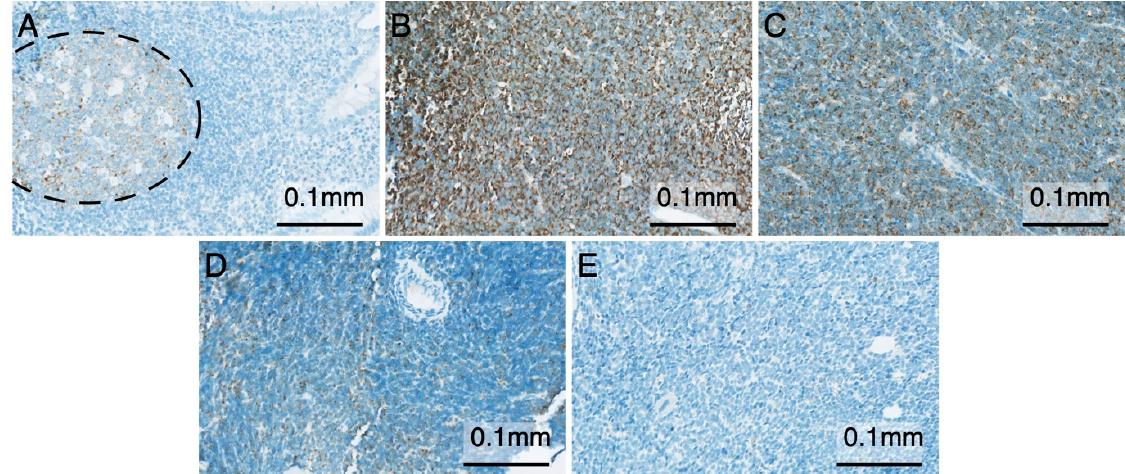
Figure 1. Immunohistochemistry of insulin-like growth factor II mRNA-binding protein 3 ( IGF2BP3 ). ( A ) Appendix showing positivity (brown color) to IGF2BP3 in the germinal center (dashed circle; 200 × magnification). ( B ) Strongly IGF2BP3 -positive bone marrow trephine biopsy of a B-cell acute lymphoblastic leukemia (B-ALL) patient (200 × magnification). ( C ) Pediatric B-ALL case with a heterogeneous pattern of IGF2BP3 expression (200 × magnification). ( D ) Weakly IGF2BP3 -positive B-ALL case with only singular positive cells visible (200 × magnification). ( E ) IGF2BP3 -negative B-ALL case (200 × magnification).